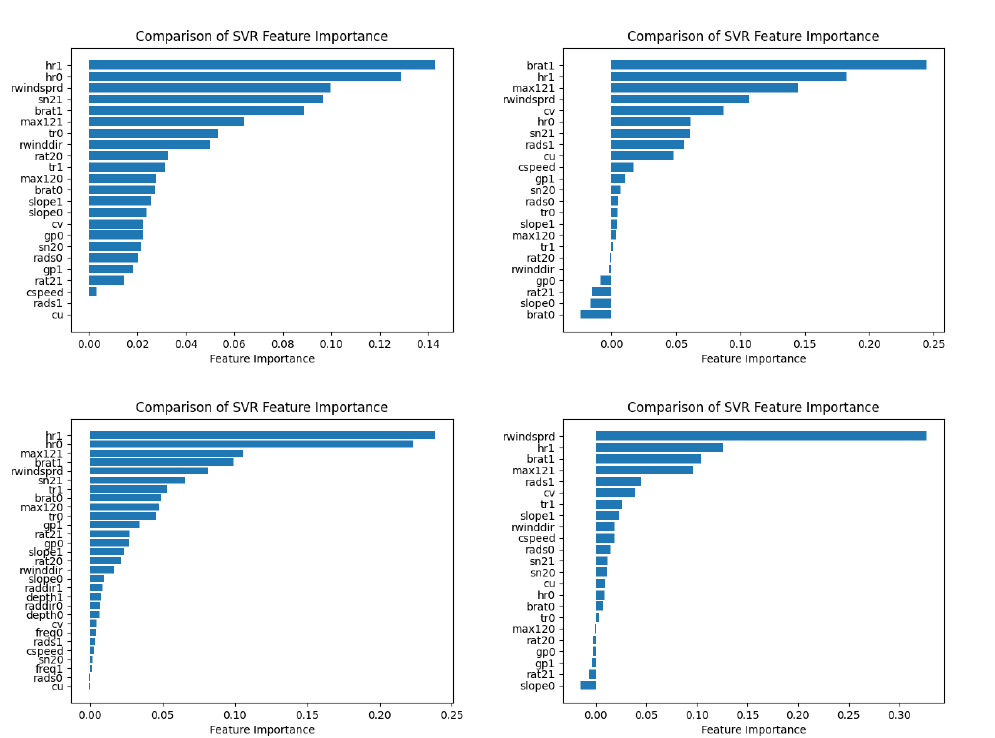
Figure 9. Relative importance of features and metocean parameters. The numbers 0 and 1 after a feature name refer to the estimates from the individual radars. Left column LB and NCS cases, right column SCS